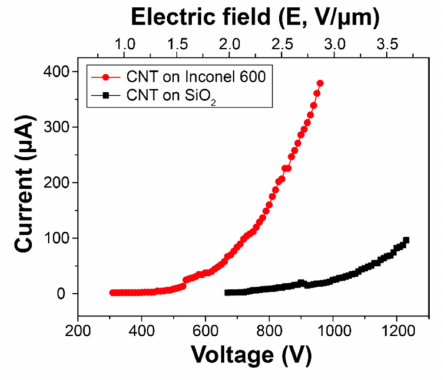
Figure 8. I–V characteristics of the CNTs grown on SiO 2 and Inconel 600 substrates.